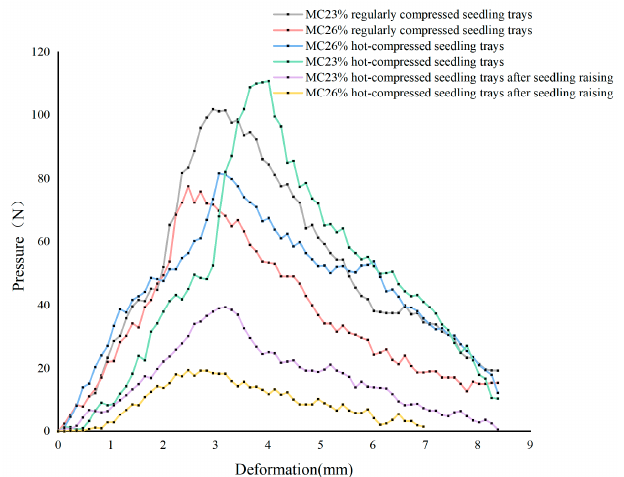
Figure 9. Bending strength results of regularly and hot-compressed seedling trays made of material with moisture contents of 23% and 26%.